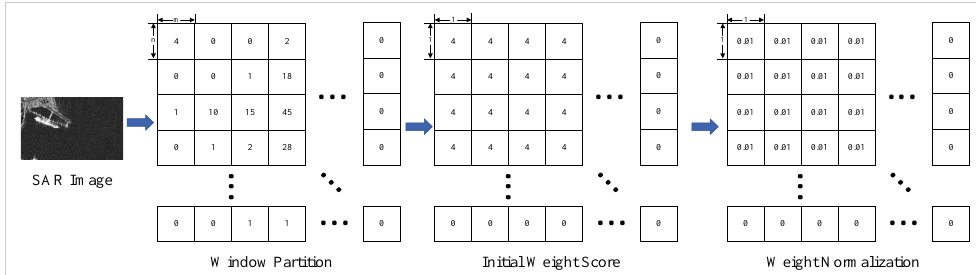
Figure 7. The schema of resizing the prior knowledge map. Details include regional division, core point statistics, assigning the initial weight, and weight normalization. The channel attention module can be divided into two branches: max-pooling and average-pooling. Max-pooling and average-pooling operations are performed on the